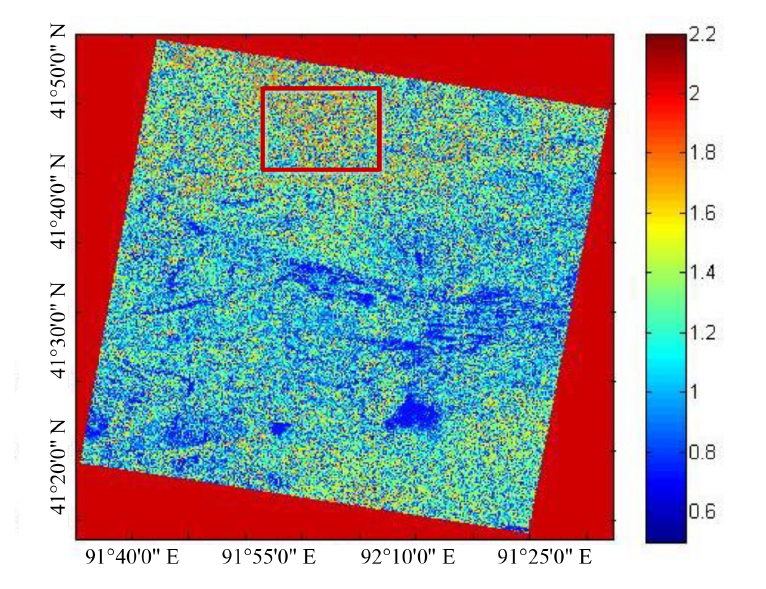
Figure 8. The Penetration depth estimation map of the test